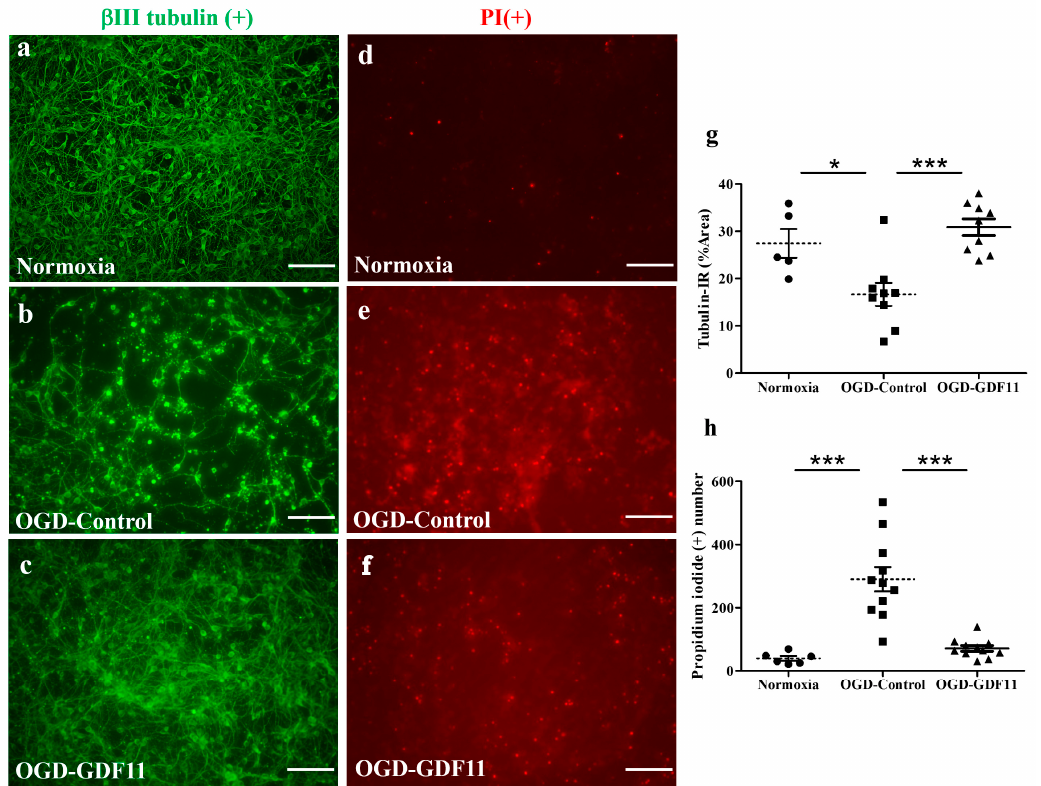
Figure 4. GDF11 protected neuron–glial cultures from oxygen glucose deprivation (OGD)-induced damage. ( a – c ) β III tubulin-IR in normoxia-control, OGD-control, or OGD-GDF11-treated cultures, respectively. ( d – f ) Propidium iodide (PI)-positive cells in normoxia-control, OGD-control, or OGD-GDF11-treated cultures. ( g ) Quantification of β III tubulin-IR neuronal density (%) per 3.56 × 10 − 3 cm 2 in normoxia and OGD-induced cultures of ( a – c ). ( h ) Quantification of PI-positive cells (PI [+] numbers per 3.56 × 10 − 3 cm 2 ) in normoxia and OGD-induced cultures of ( d – f ). The results are reported as mean ± SEM in each group from three independent experiments. * p < 0.05 Normoxia versus OGD-control, *** p < 0.001 indicates a significant difference between the